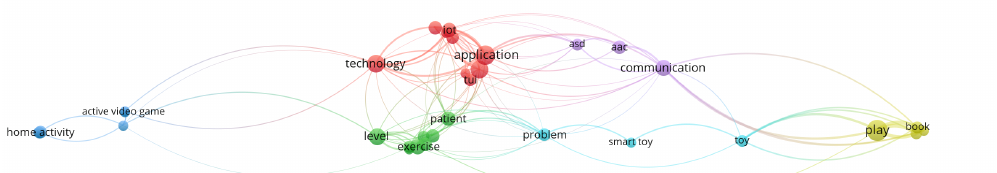
Figure 4. Co-occurrence of automatically generated keywords in selected bibliography for litera- ture review.